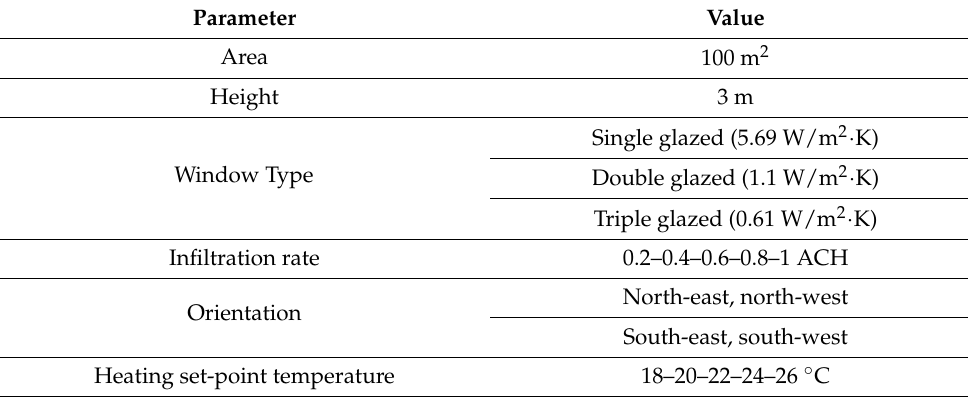
Table 2. Main design parameters of the